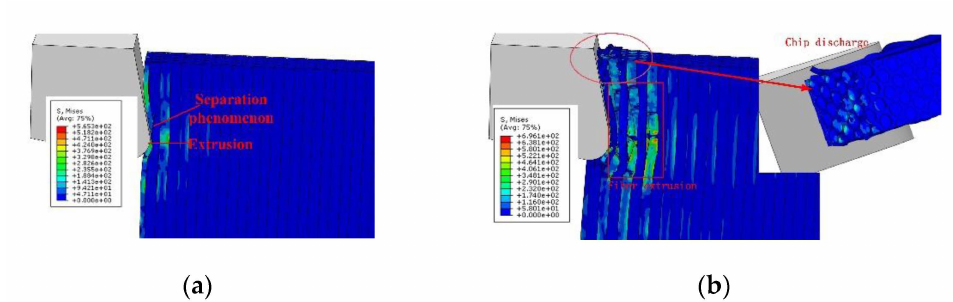
Figure 6. Stress (von Mises) values of the CFRP workpiece calculated with the FE model, with fiber angle θ = 90 ◦ , showing the initial extrusion ( a ) and the chip formation ( b ). The workpiece was fixed at the bottom